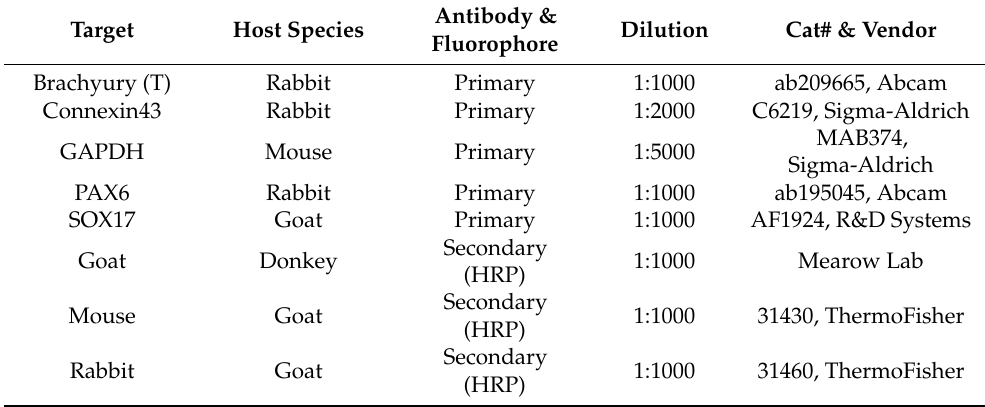
Table 2. Primary and secondary antibodies used in western blotting.